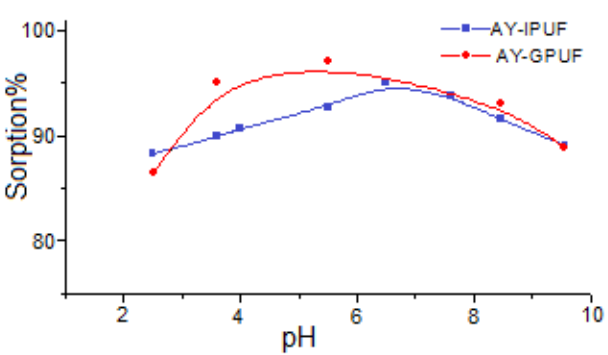
FIGURE 9 - The effect of sample pH on the sorption of CAF: